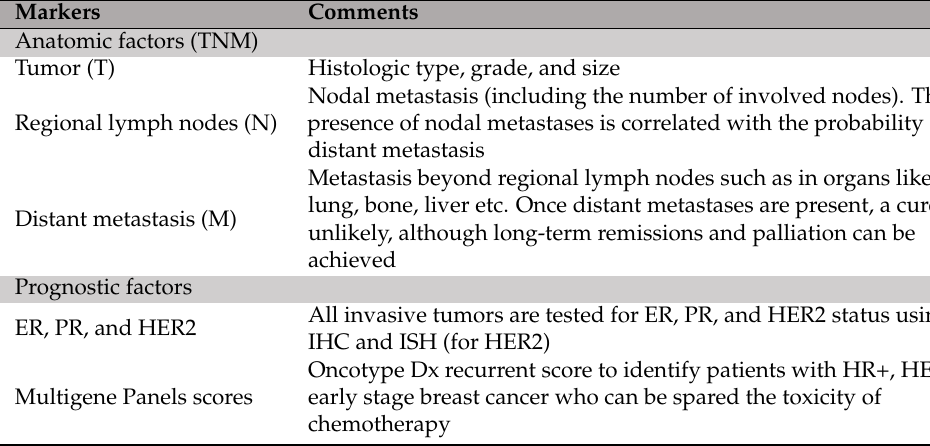
Table 1. Prognostic and Predictive Biomarkers in BC Staging in AJCC 8th.